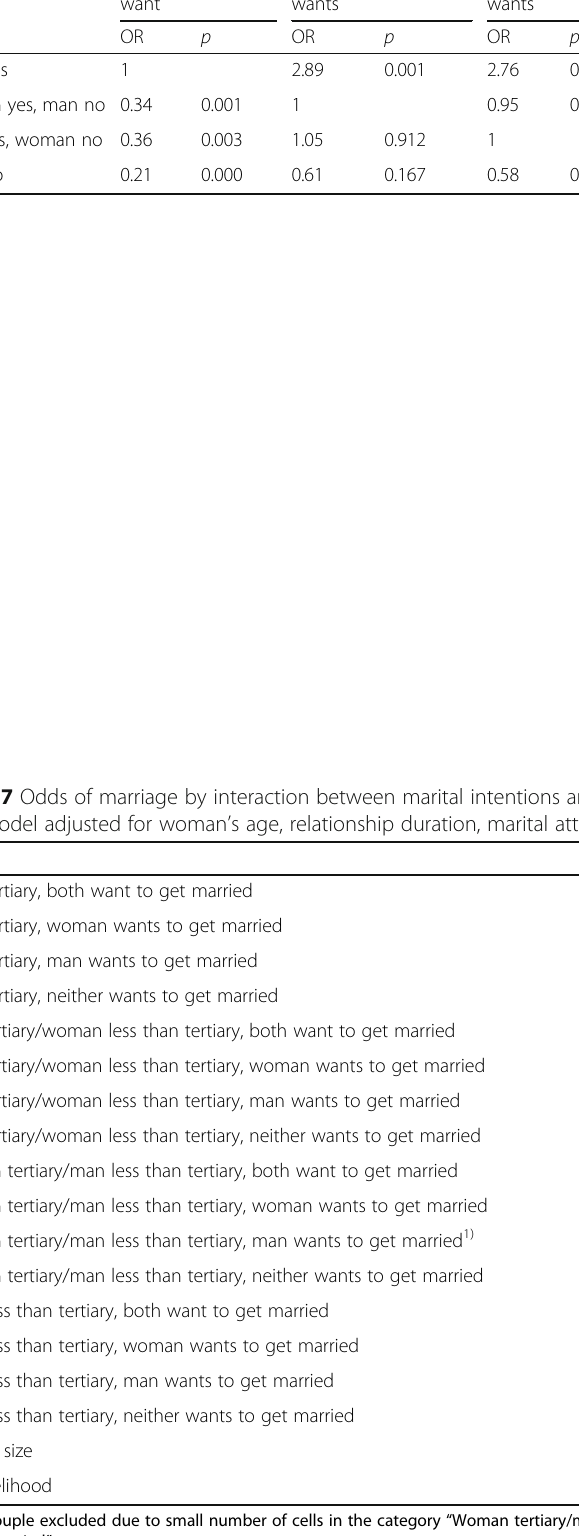
Table 6 Odds of marriage by marital intentions among cohabiting couples, bivariate models ( n 507) Reference: both Reference: woman Reference: man Reference: neither want wants wants wants OR p OR p OR p OR p Both yes 1 2.89 0.001 2.76 0.003 4.79 0.000 Woman yes, man no 0.34 0.001 1 0.95 0.912 1.66 0.167 Man yes, woman no 0.36 0.003